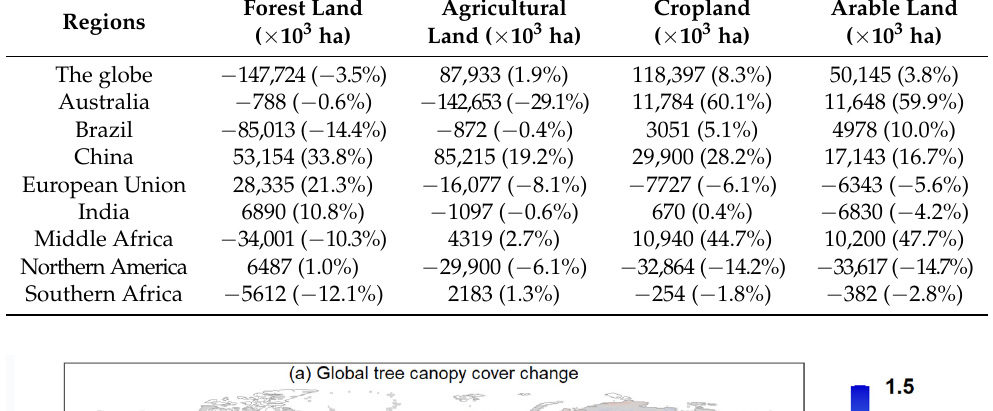
Table 1. Global land-cover area changes during 1982–2015. Limited by the observation, the forest land change is calculated by using the data covering 1990–2015.